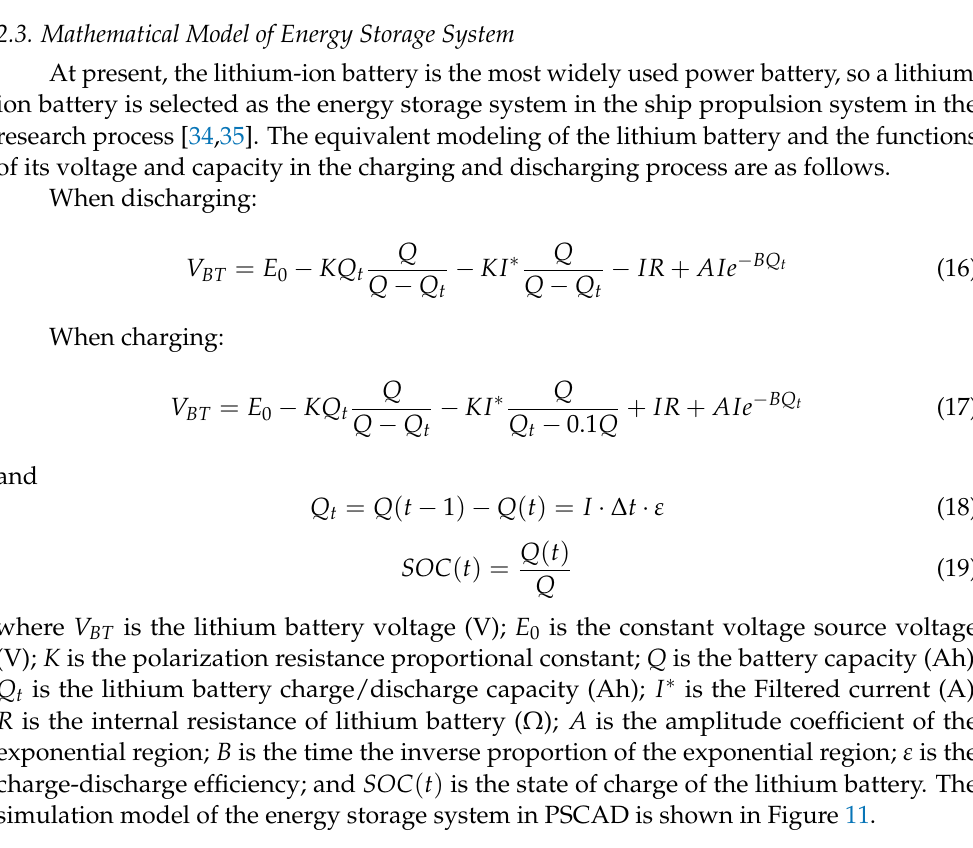
Figure 10. Model of a doubly-fed wind power generation system.